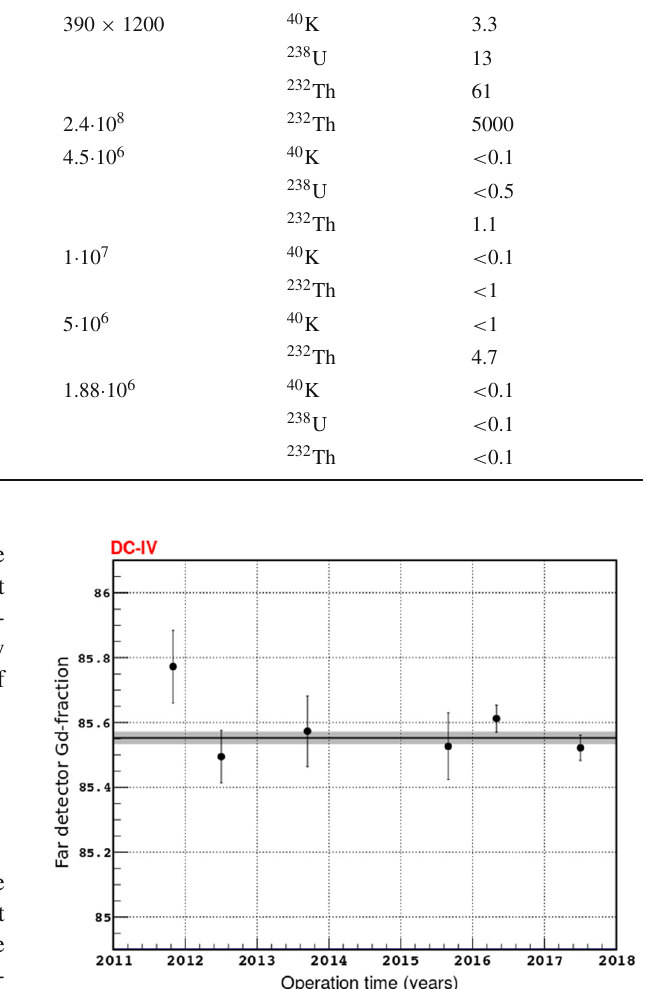
Table 3 Measurements of the concentration of radioimpurities in the detector elements contributing most to the singles event background